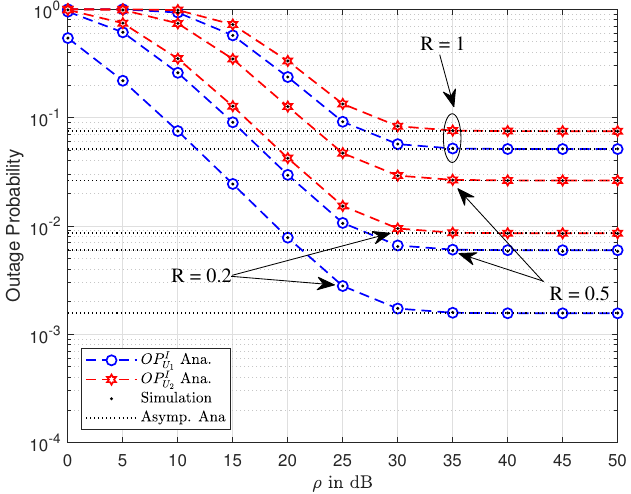
Figure 2. Outage performance of U 1 and U 2 versus ρ with varying R .